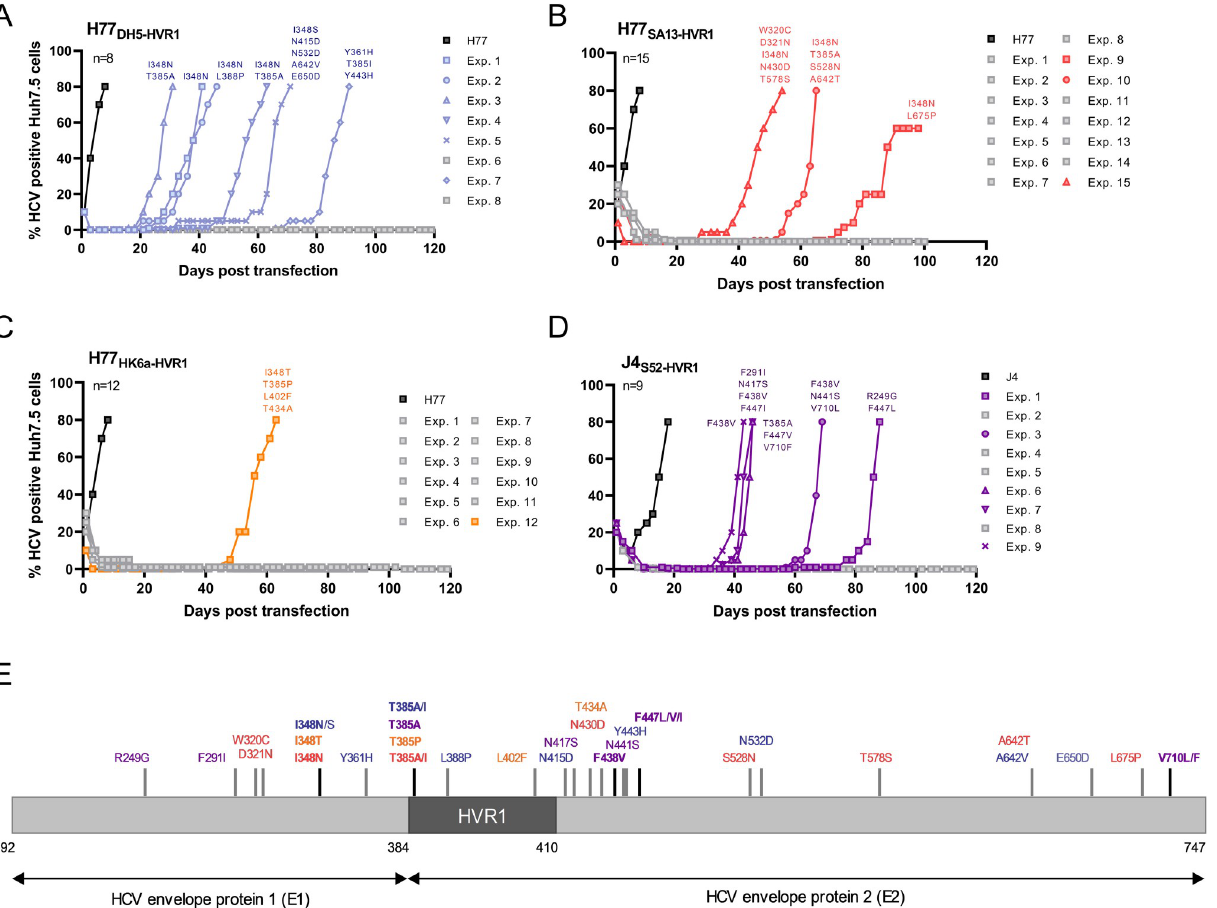
Fig 1. Insertion of HVR1 from DH5, SA13 and HK6a into H77 or S52 HVR1 into J4 attenuates the recombinant HCVcc. (A-D) Adaptation of the HVR1-swapped viruses in Huh7.5 cells during the indicated time period. The cells were transfected with the indicated in vitro transcribed HCV RNA of the indicated recombinants. Viral spread was monitored by immunostainings of infected cells and sequence analysis was performed on amplified envelope protein encoding nucleotide sequences of the cell culture adapted HVR1-swapped recombinants. Spread of a representative parental H77 (A-C) and J4 (D) recombinant is shown in black in all panels. Only coding mutations are depicted. Gray squares indicate cell cultures that were closed due to infection suppression, as evidenced by the absence of antigen-positive cells for at least two weeks. (E) Schematic overview of the envelope proteins with the identified coding mutations color-coded according to which HVR1-swapped recombinant they were identified in (colours correspond to those shown in panels A-D). Amino acid positions are based on H77 abs. ref. (Genbank #AF009606); HVR1 corresponds to positions 384–410.